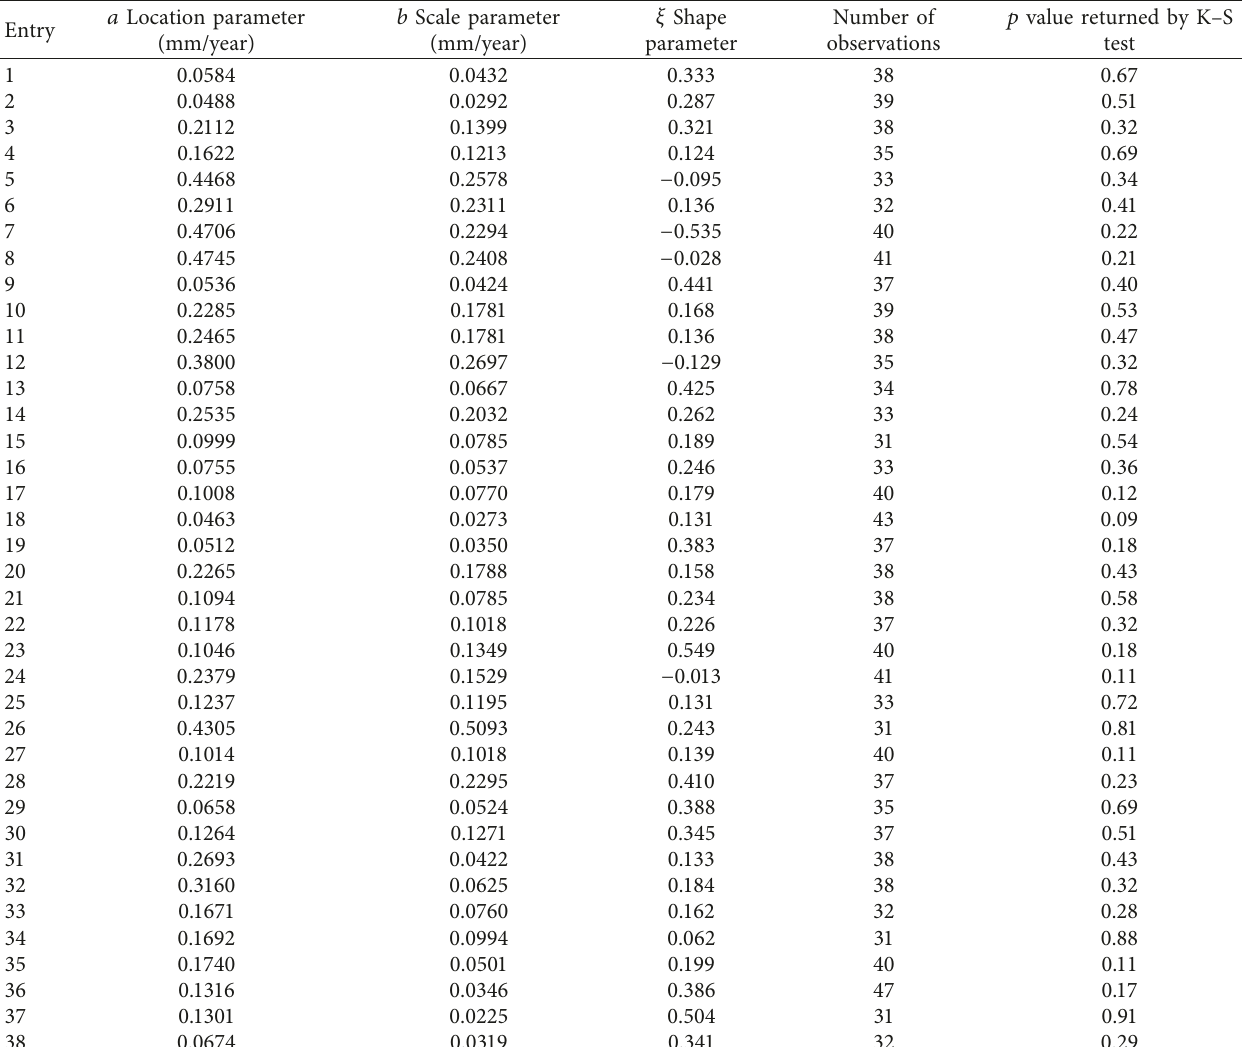
Table 1: Generalized Extreme Value Distribution parameters after fitting wall thickness thinning rate data, number of observations, and p value returned by K–S test from thirty-eight low alloy steel shell heat exchangers used in middle distillate units to preheat the feed with the effluent from the